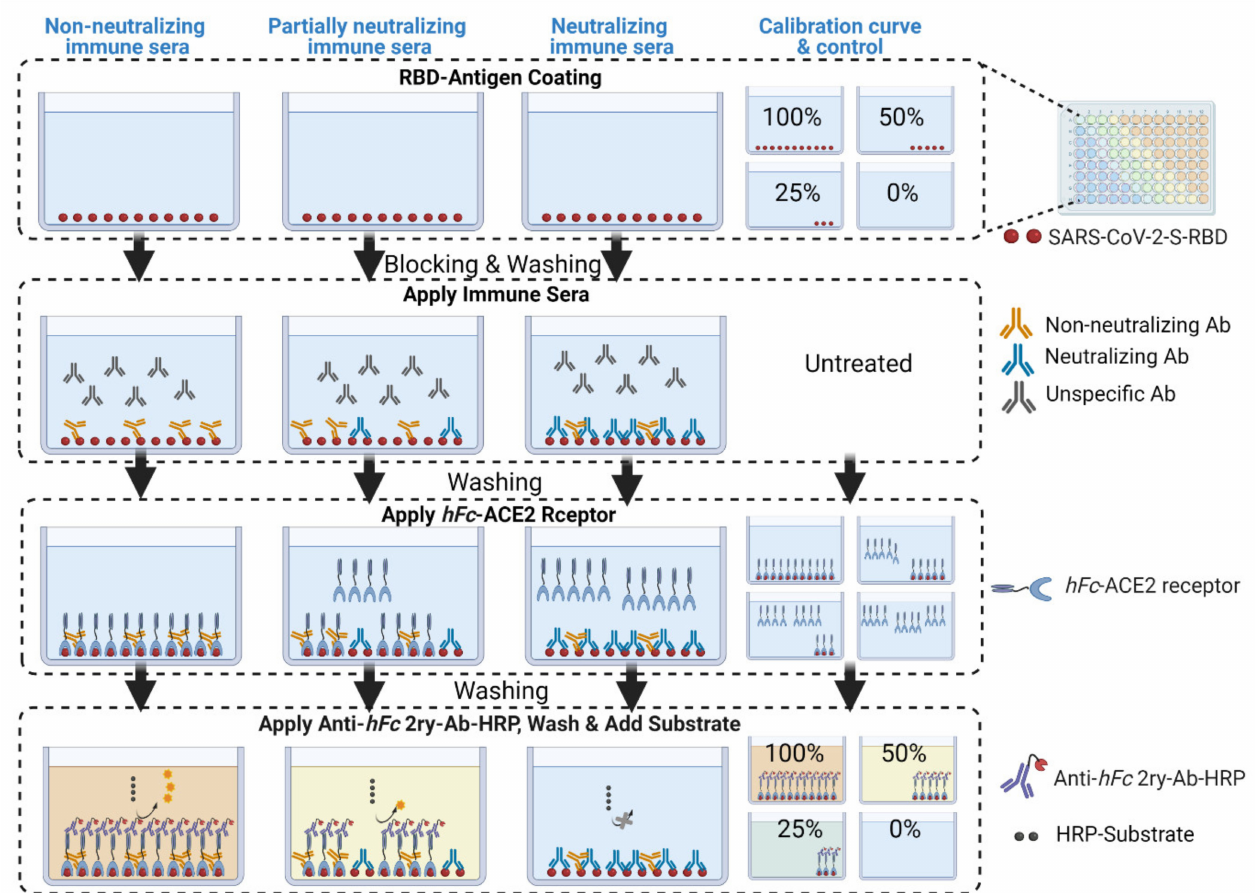
Figure 3. Schematic diagram depicting the cELISA processing steps and expected outcomes. RBD antigen is coated onto sample plates and, in different amounts, onto a calibration curve plate. The wells are blocked with 2% BSA solution to prevent further non-specific